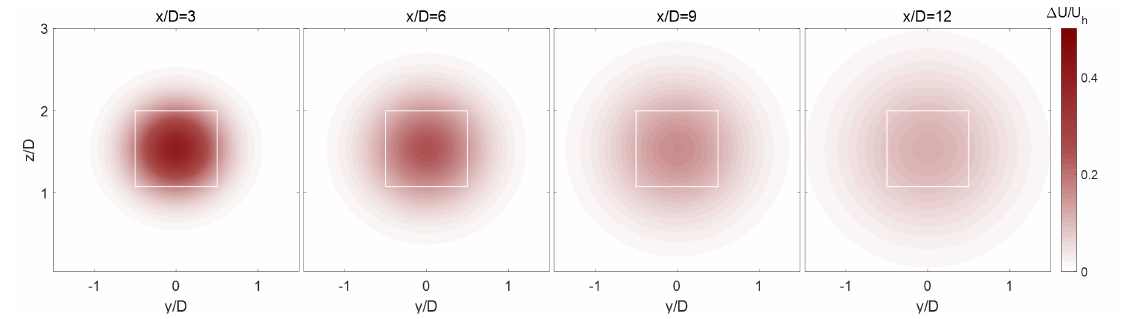
Figure 9. Same as Figure 7 but obtained from the Gaussian-type wake model.